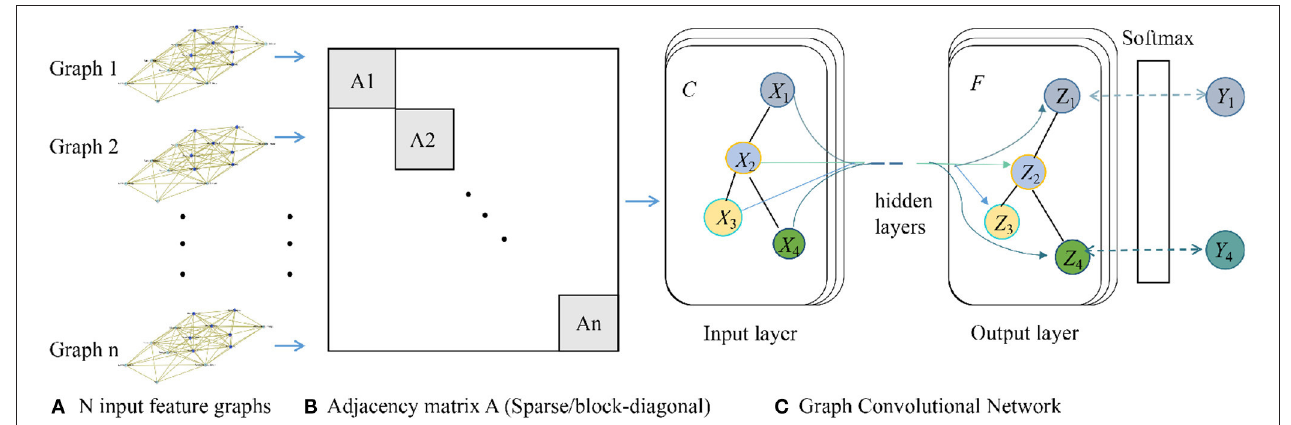
FIGURE 3 | Architecture of our graph convolutional network (GCN)